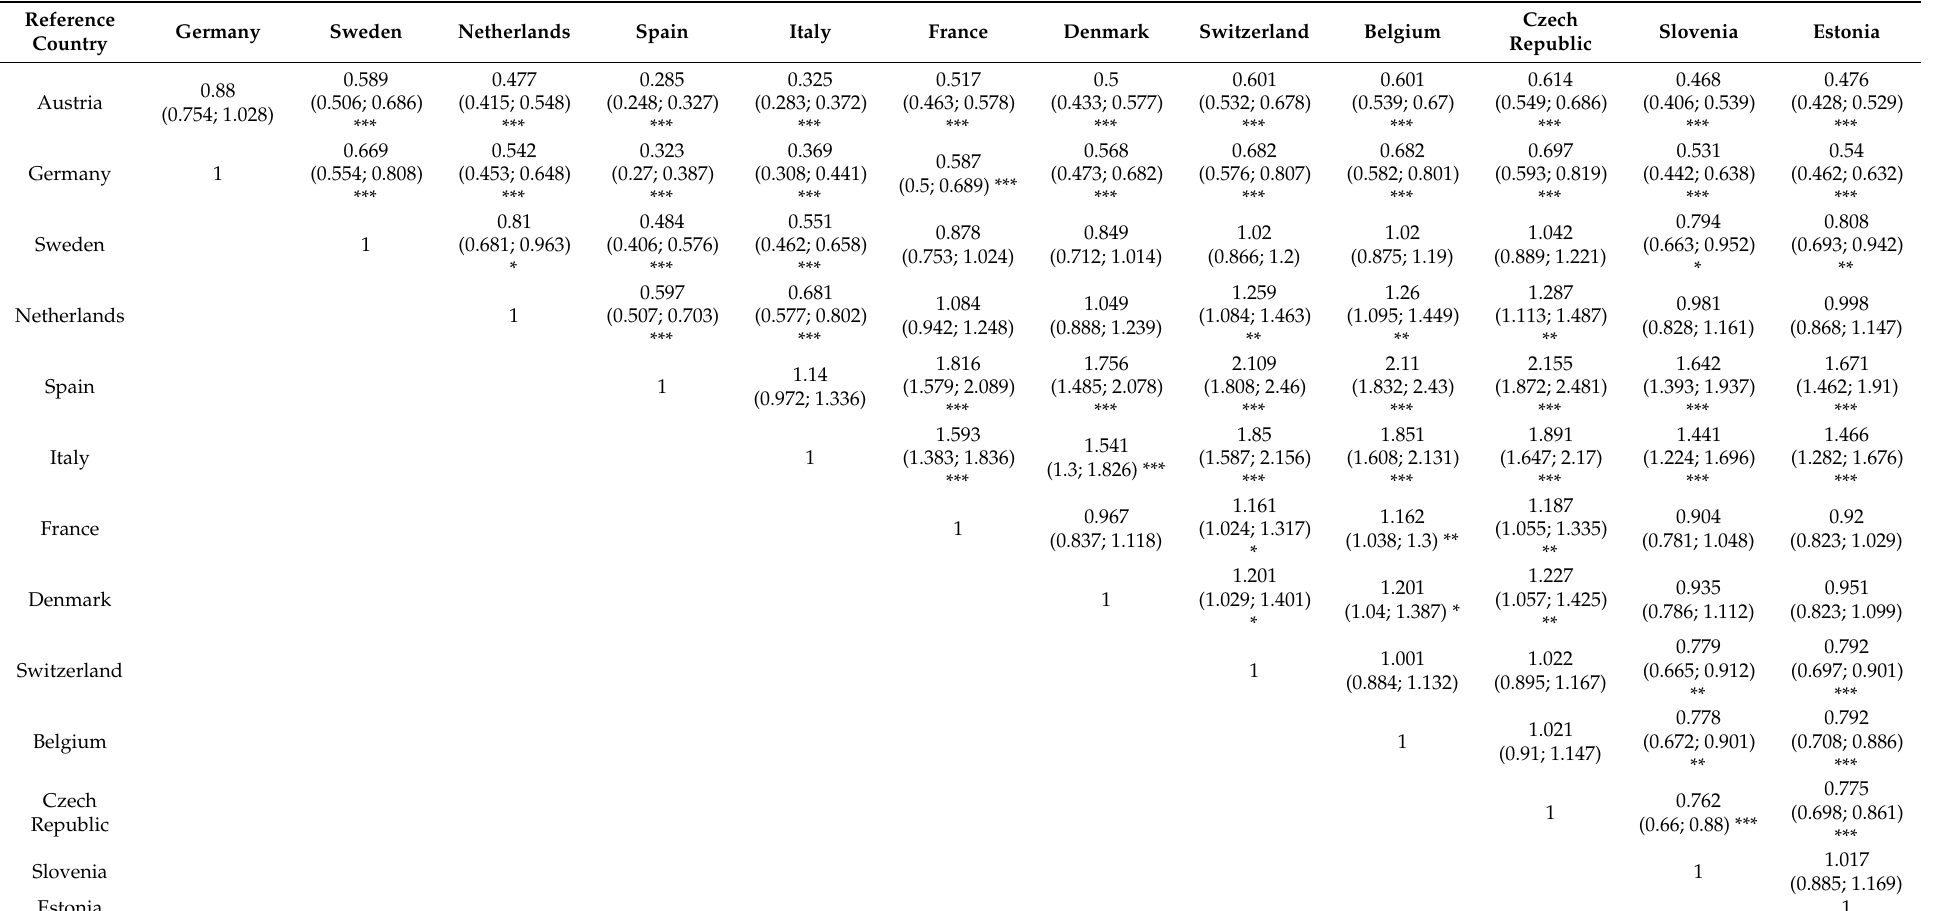
Table 3. Countries odds ratio of logit panel model changing reference country for hospitalization in the last 12